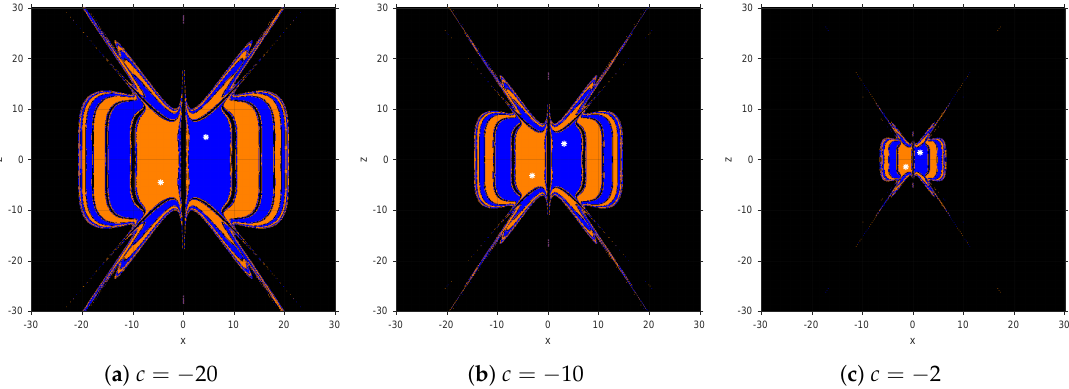
Figure 4. Dynamical planes of TM1 method on p c ( x ) = x 2 + c for different values of c . Color basins: ( c ) orange, x F ( c ) blue, no convergent points in x F 2 1